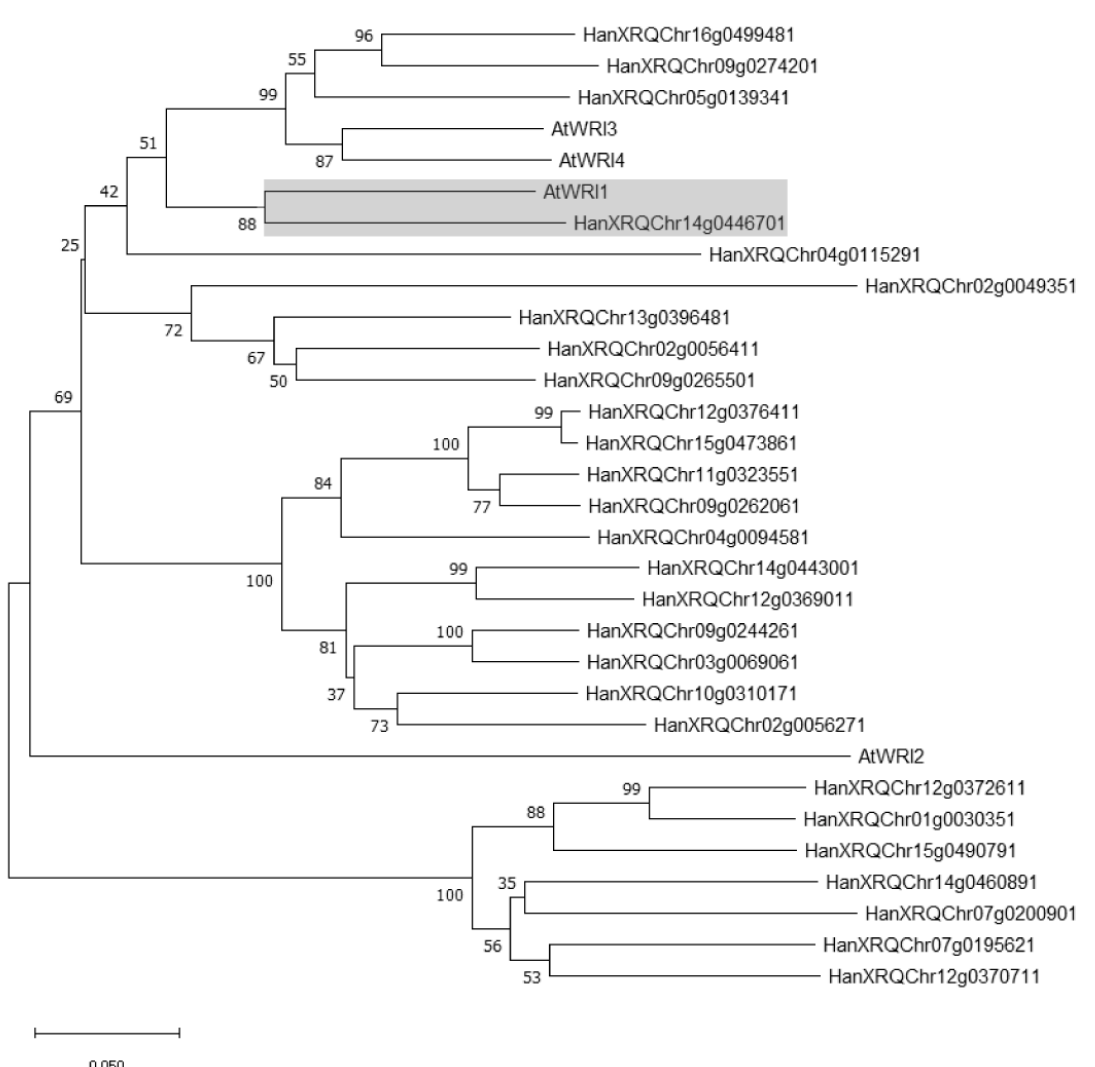
Figure 1. Phylogenetic analysis of AtWRI1 homologs from H. annuus . The phylogenetic tree